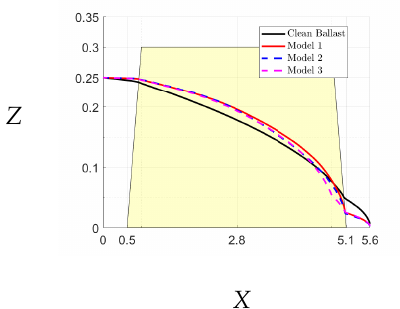
Figure 17. Free-surface for realistic railway ballast at height h 1 = 0.25.